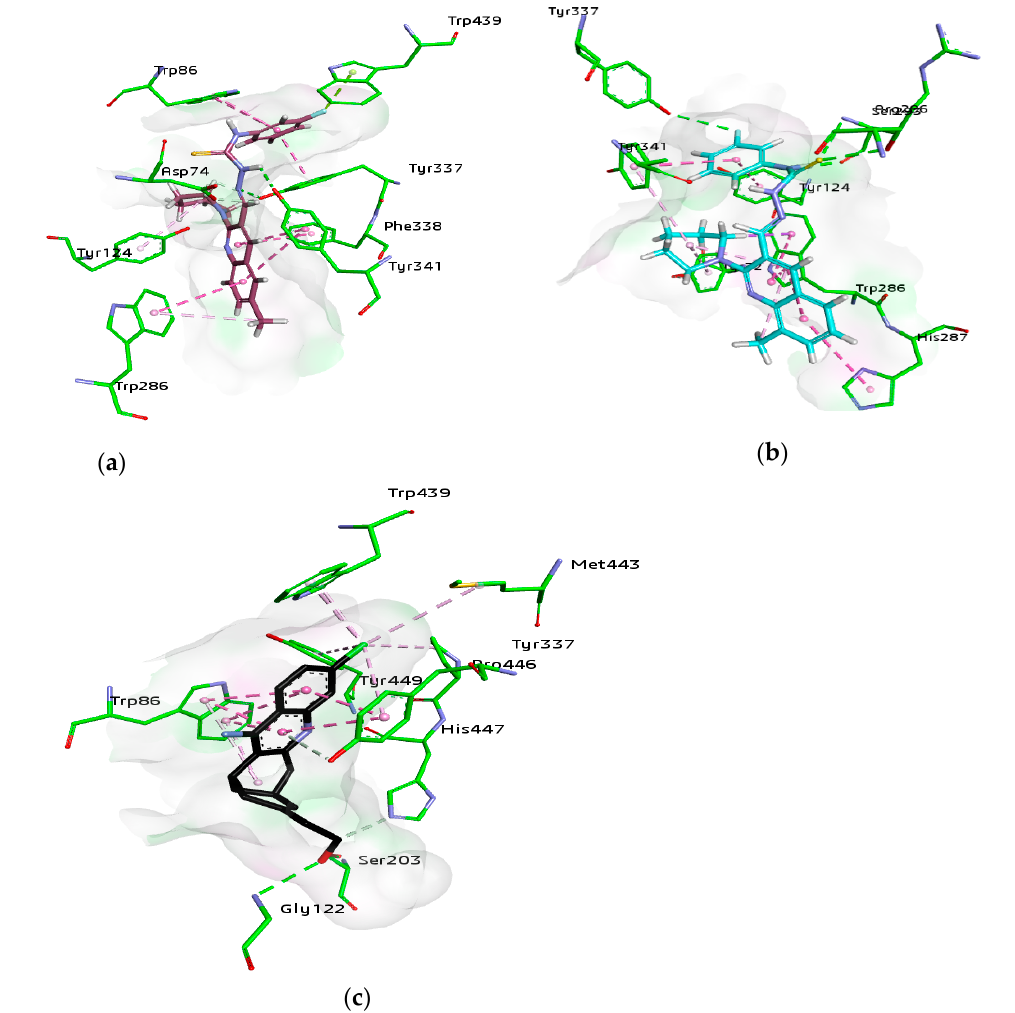
Figure 6. 3D binding modes of 5i ( a ), 6i ( b ), and Huprine W ( c ) with the amino acid residue of AChE, hydrogen bonding is shown by green dashed line, hydrophobic interactions are shown by light purple color, dark pink dashed lines show π -T shaped, light pink color shows π - π stacked interactions, and purple color dashed lines show π -sigma type interactions.